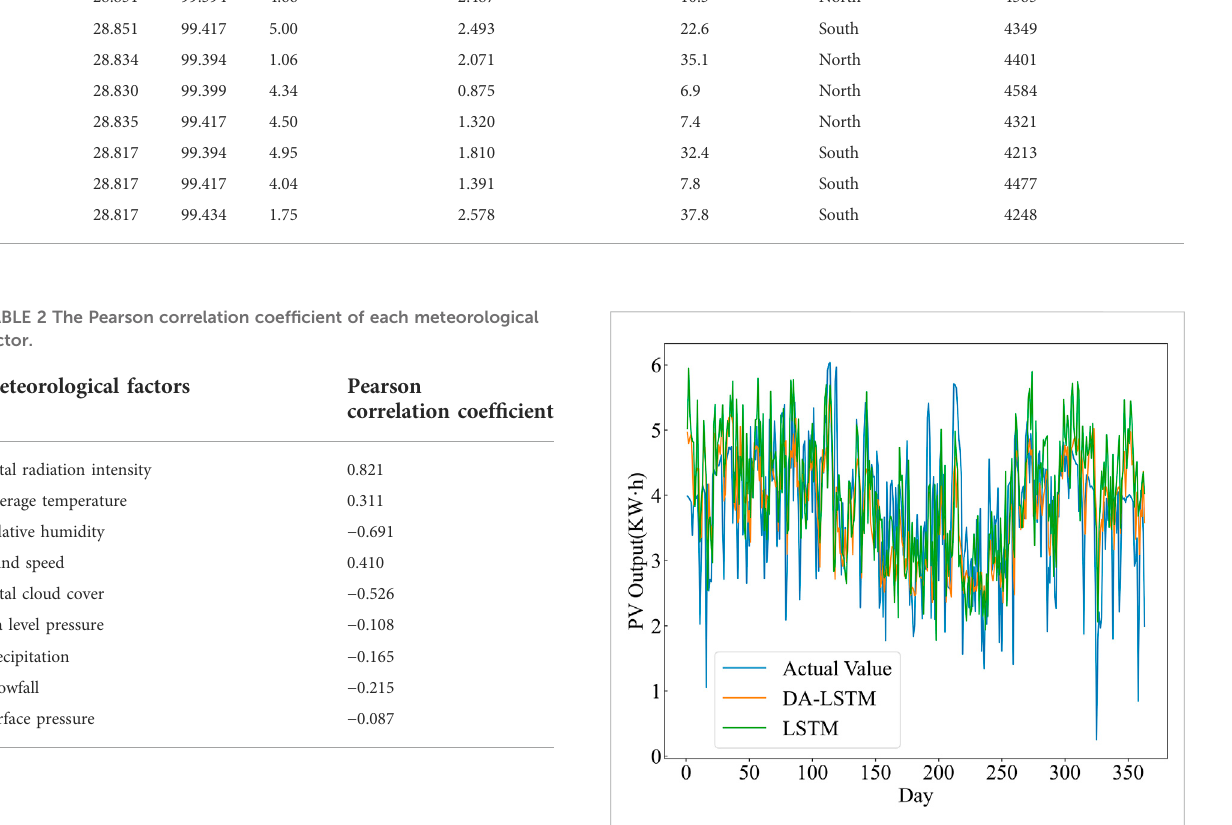
FIGURE 4 The actual value and the results of different models.